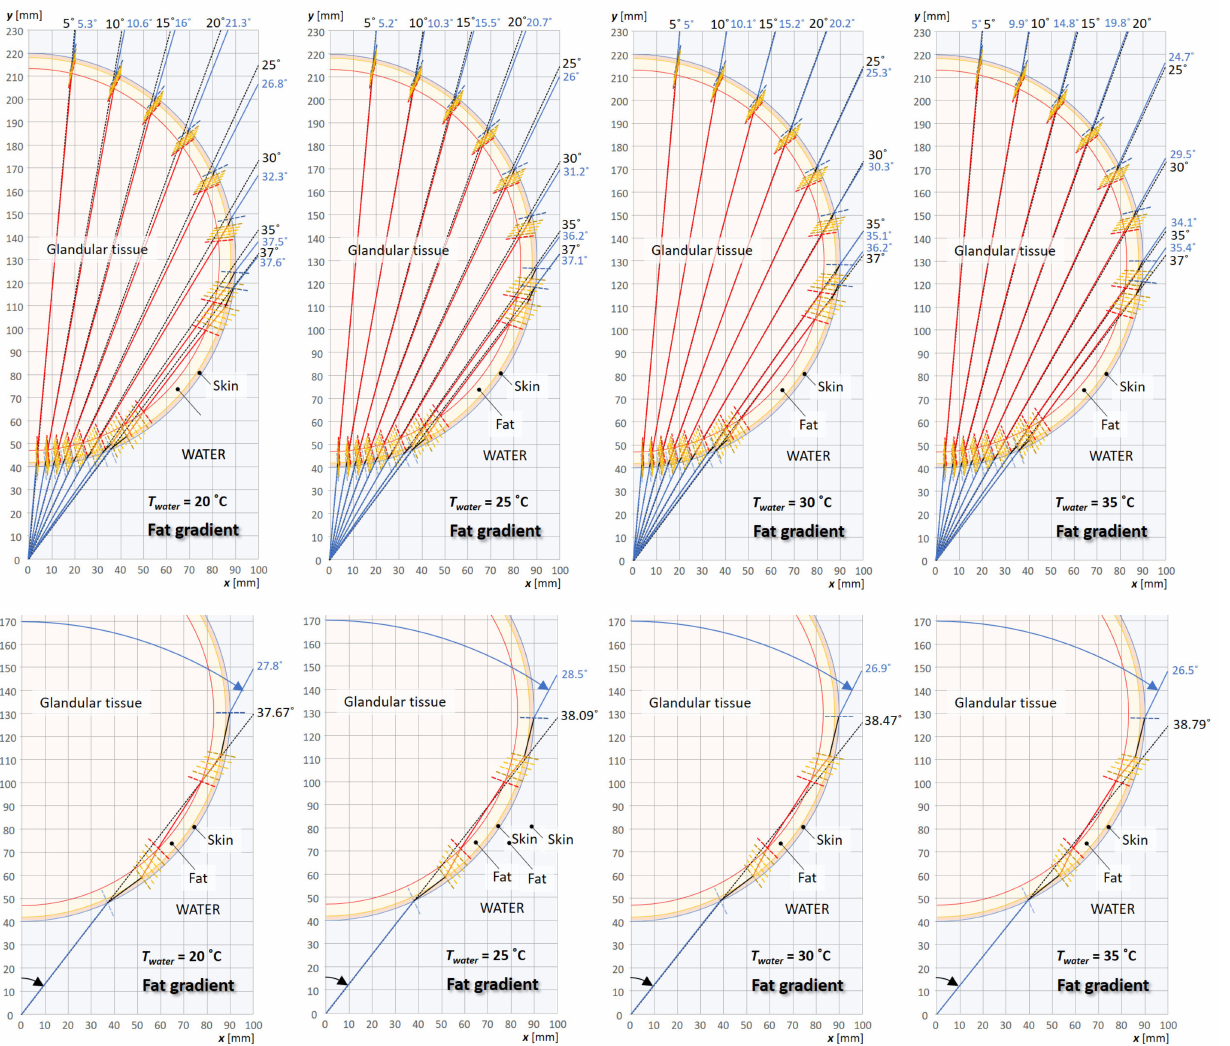
Figure 10. Results of calculating the refraction of the incident ultrasonic wave beam rays from water on curvilinear breast layers with temperature gradient in fat (see the model in Figure 8b) for angles of beam rays in the range of, respectively, 5–37 ◦ (first row), as well as for the maximum possible values of the angle of beam ray still allowing this ray to pass through all layers (second row), for temperatures of 20 ◦ C, 25 ◦ C, 30 ◦ C, and 35 ◦ C